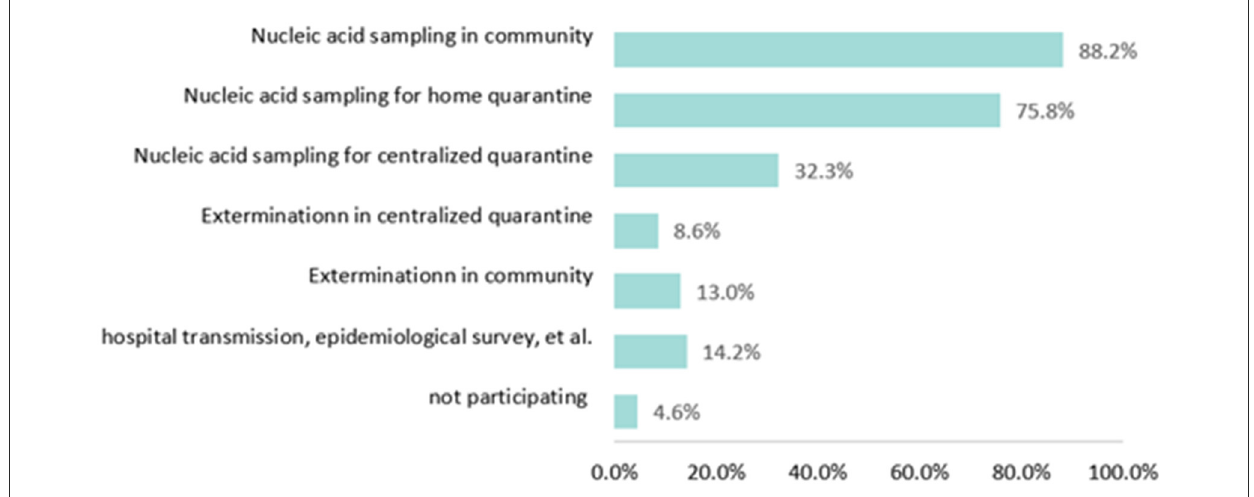
FIGURE1 Distribution of different types of COVID-19 prevention and control work.